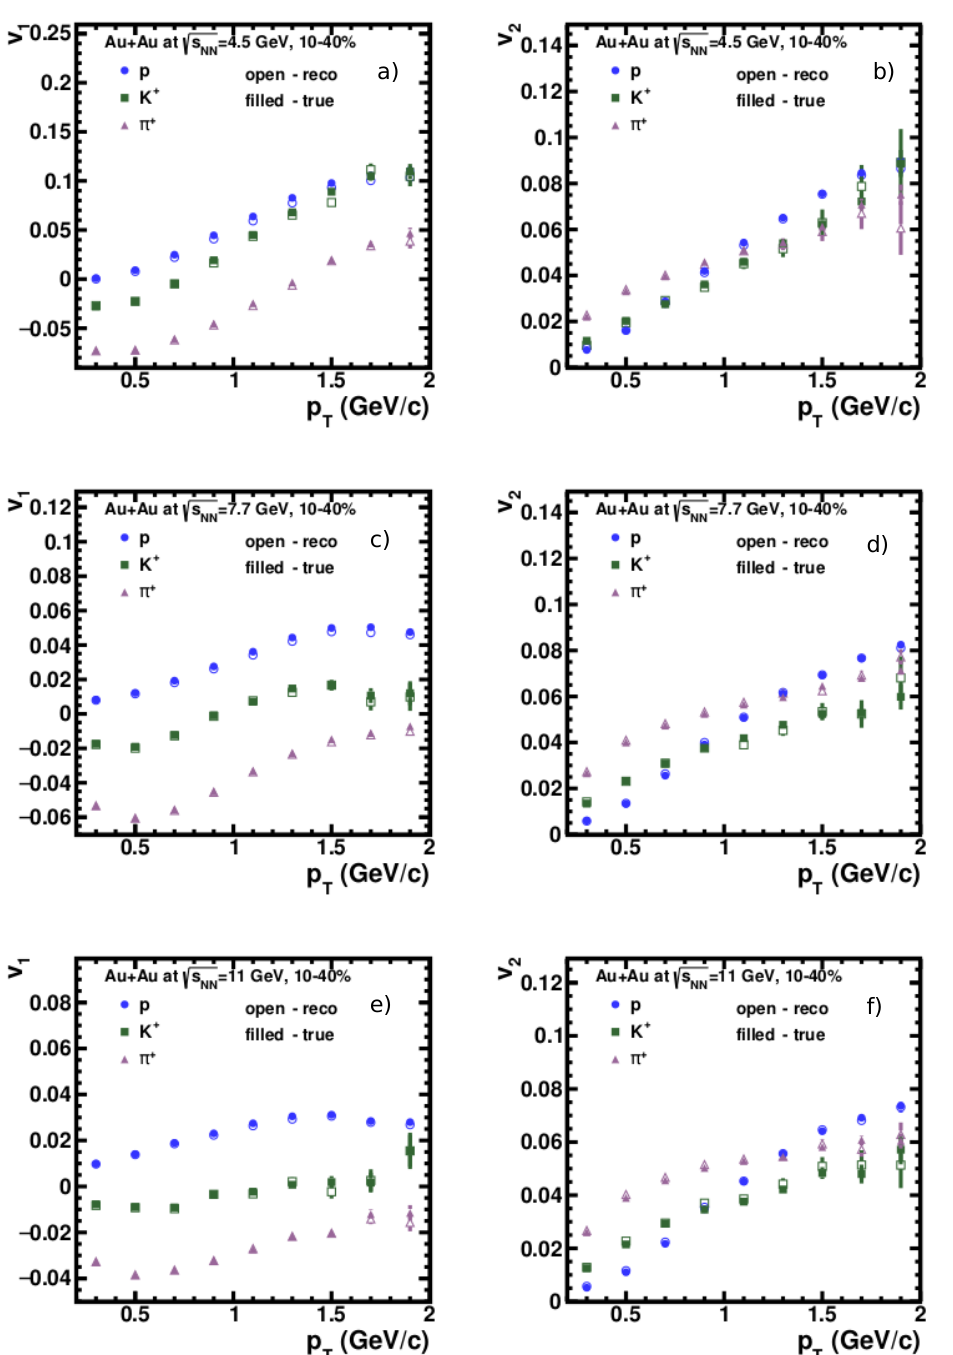
Figure 10. p T dependence of directed v 1 ( left panels) and elliptic v 2 flow ( right panels) of charged pions, kaons and protons for 10–40% central Au + Au collisions at The open symbols correspond to v n results from the analysis of the fully reconstructed events (“reco”) and closed symbols to the results from generated (“true”) UrQMD